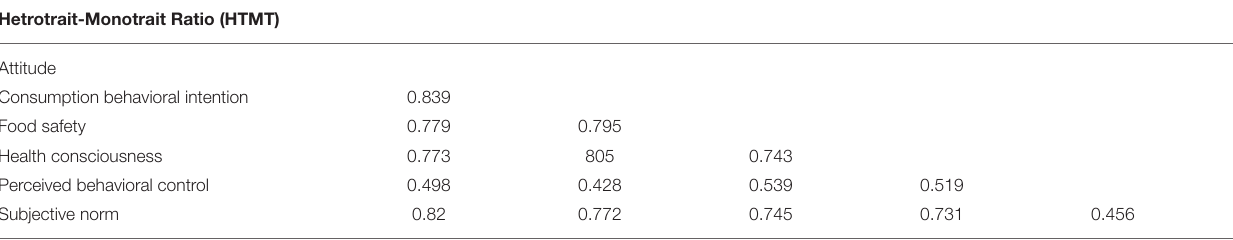
TABLE 3 | Discriminant validity assessment ( n = 462). Hetrotrait-Monotrait Ratio (HTMT)